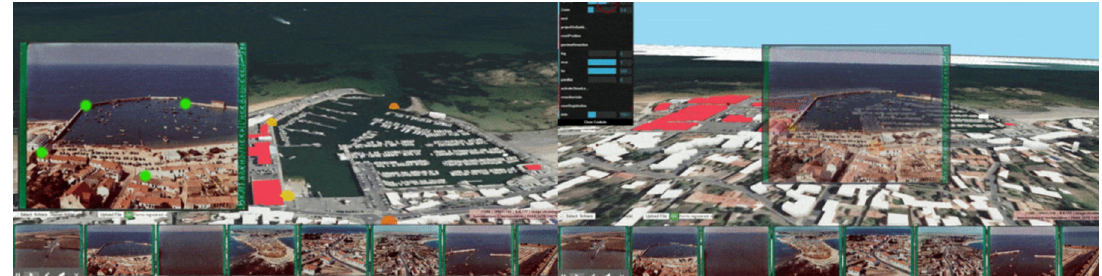
Figure 4. Semi-automatic localization of an image with iTowns: (left) Image registration with 4 pairs of user inputs (green points on the source image and orange points in the 3D reference. (right) Registered image in the 3D scene.